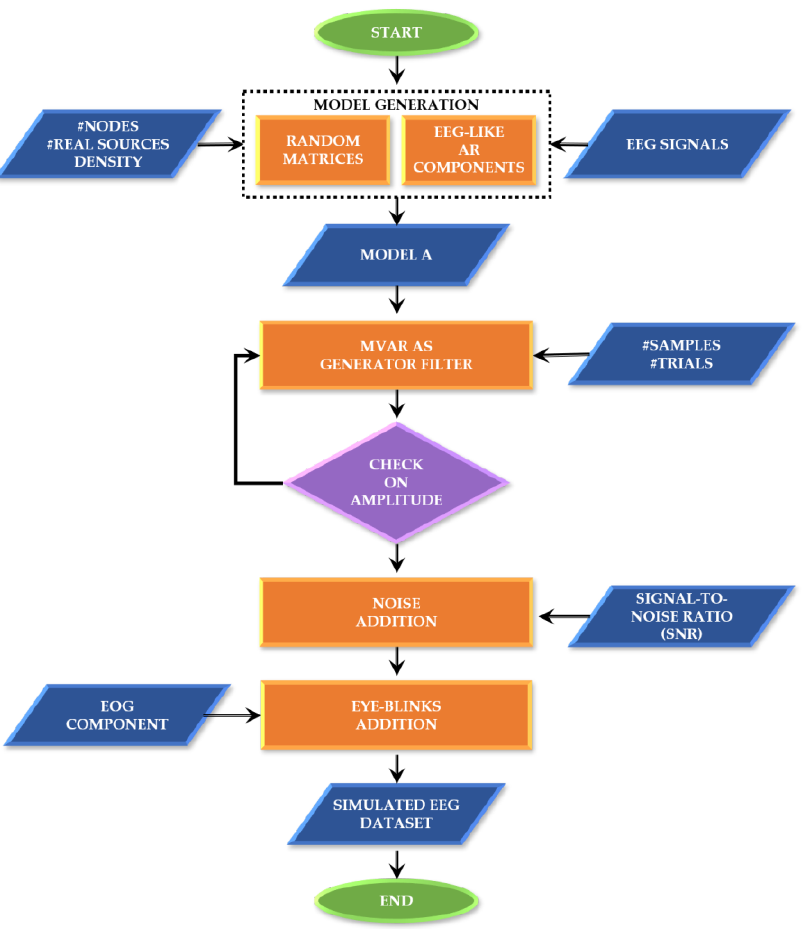
Figure 1. SEED-G generator framework. Block diagram describing the main steps at the basis of the data